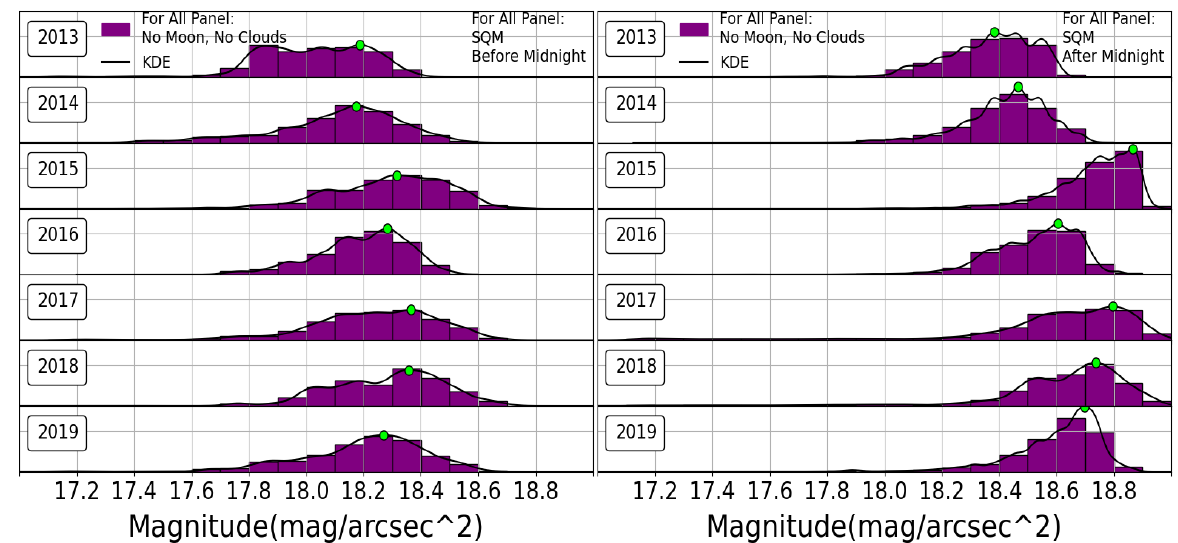
Figure 12. SQM histograms for filtered data showing night sky brightness values before (left) and after midnight (right). The green points represent the mode.